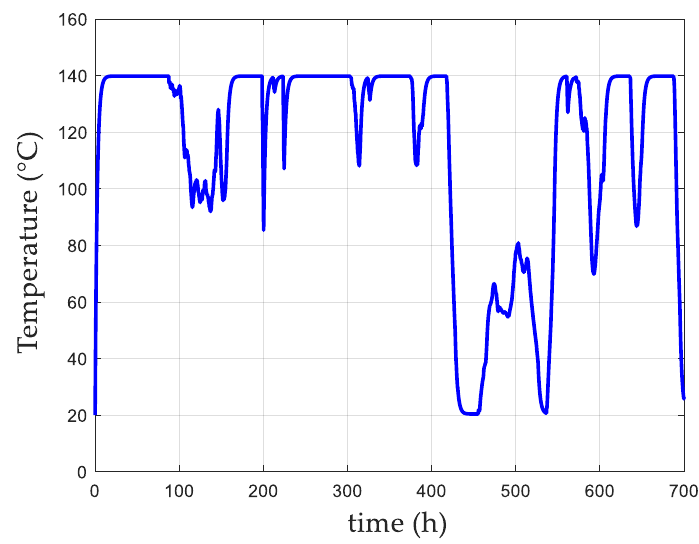
Figure 10. Evolution of the temperature in the winding.